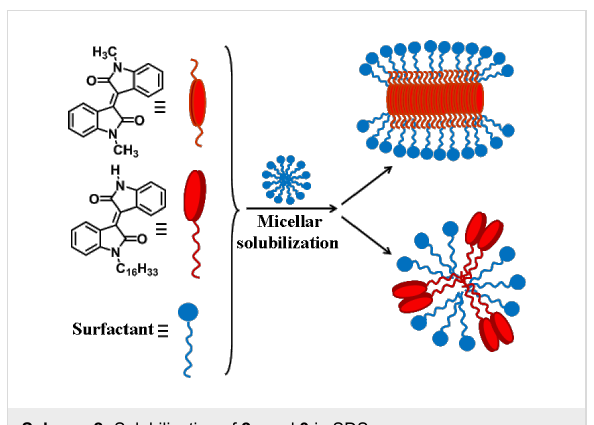
Scheme 2: Solubilization of 2a and 3 in